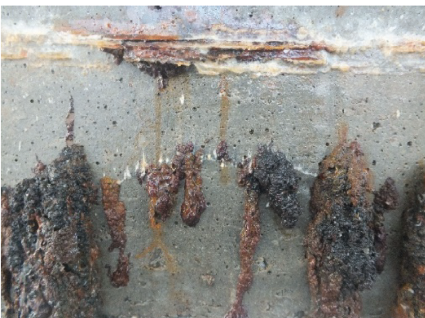
Figure 8: Rust products ooze